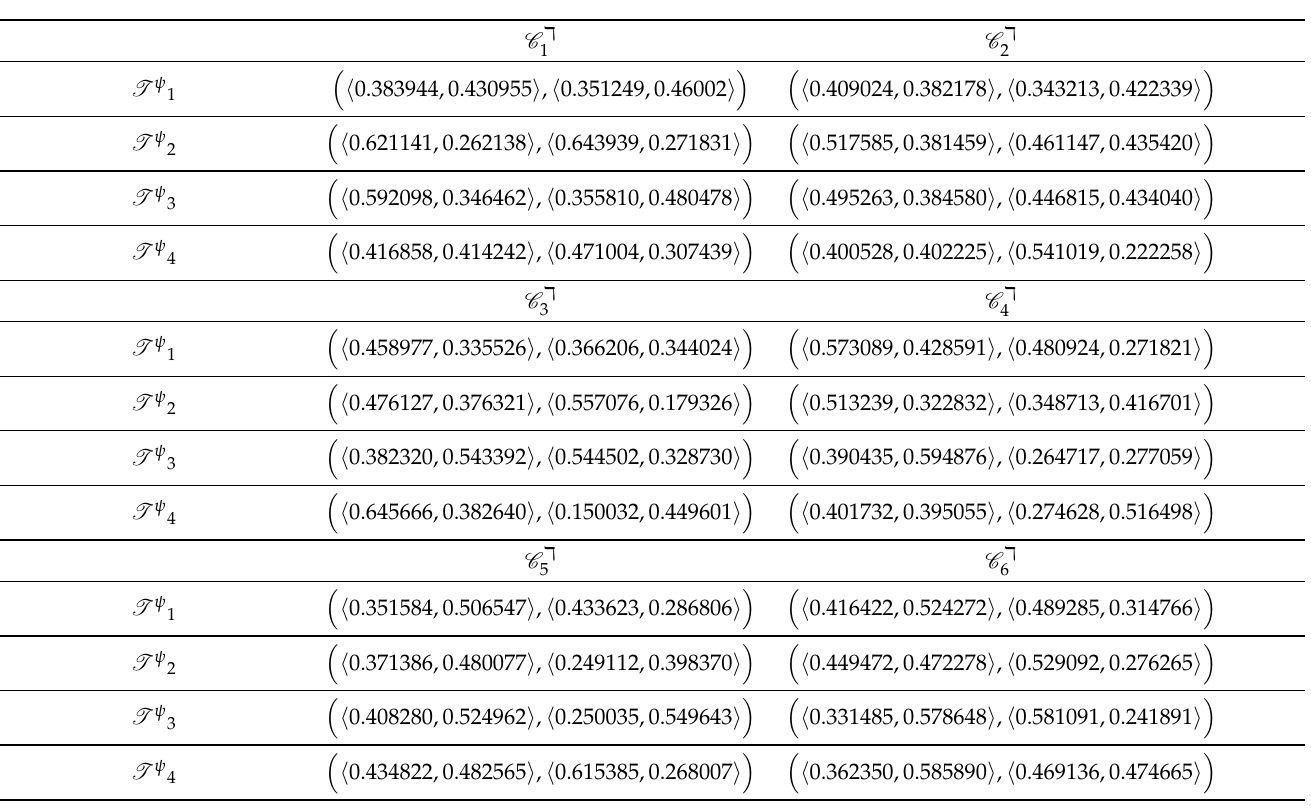
Table 9. Normalised LDF decision